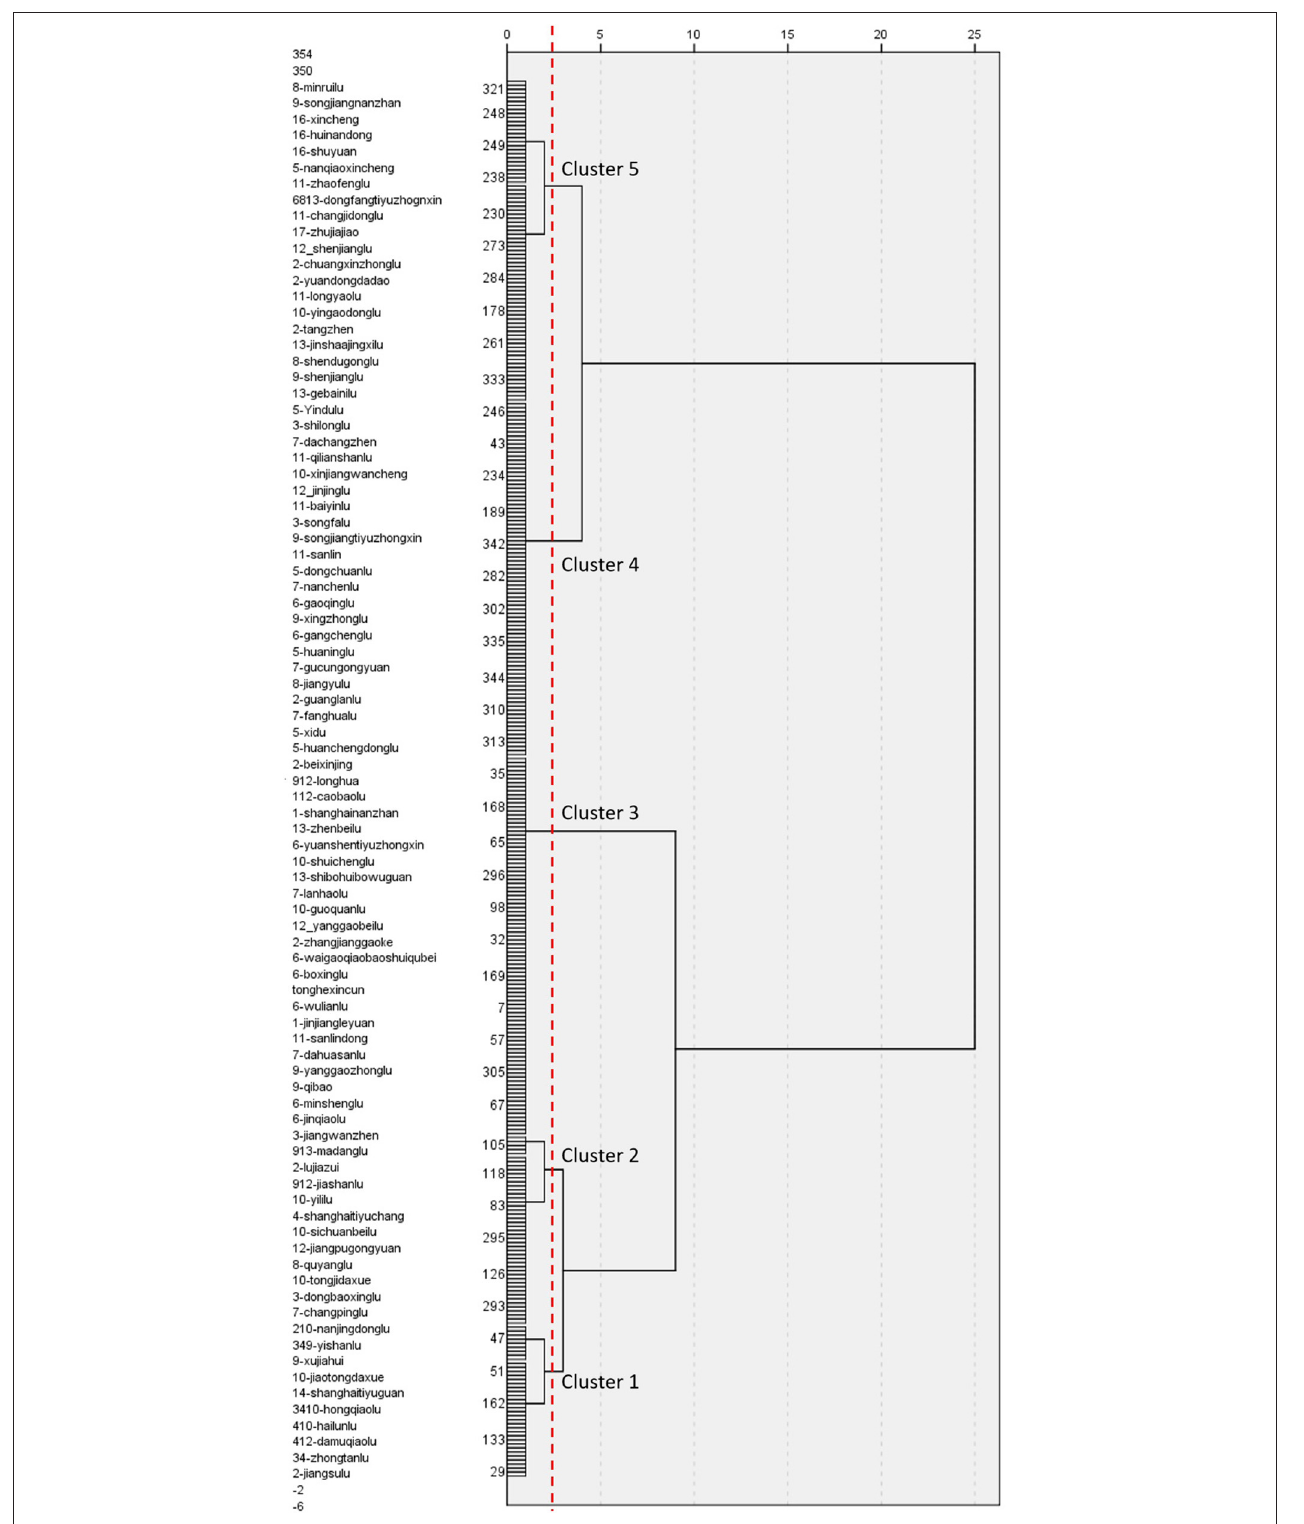
FIGURE 8 | The hierarchical cluster analysis is based on three